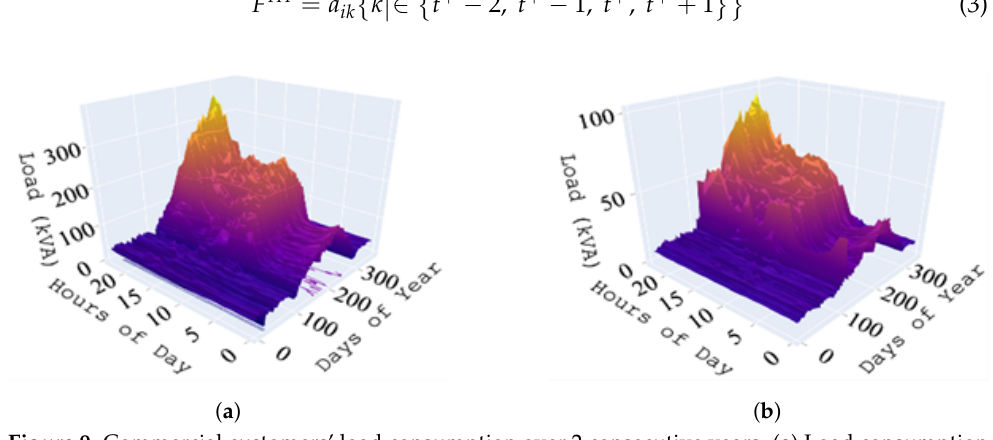
Figure 9. Commercial customers’ load consumption over 2 consecutive years. ( a ) Load consumption in 2018. ( b ) Load consumption in